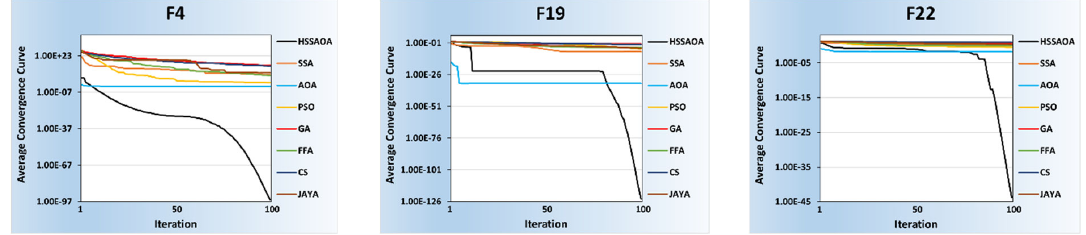
Fig. 6 Logarithmic convergence curve of some functions according to Group